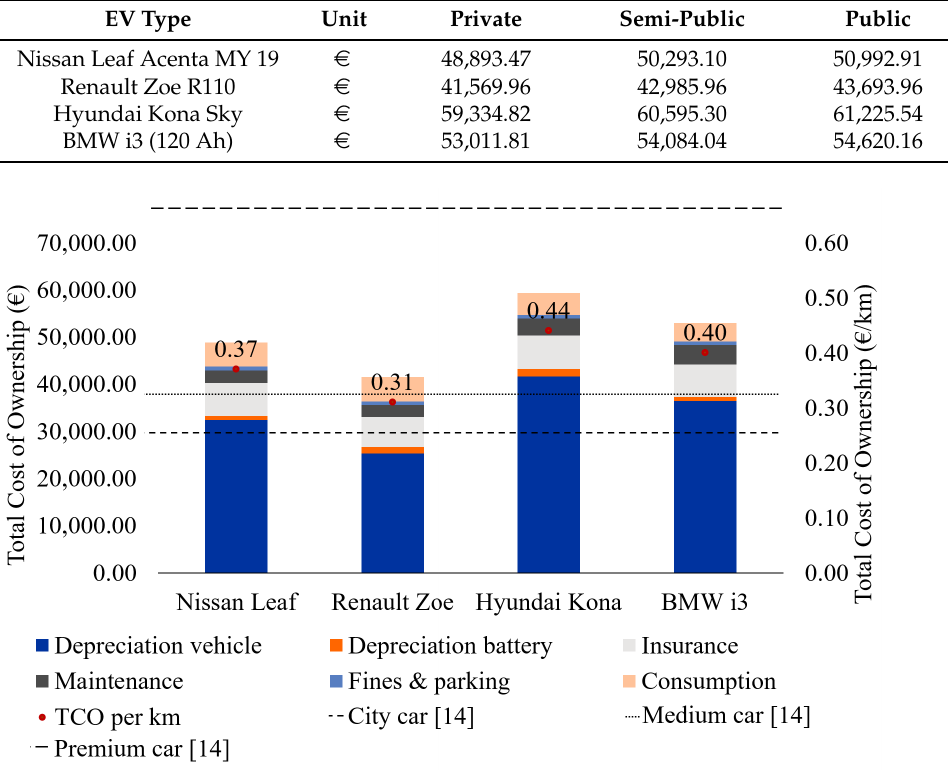
Table 9. TCO without V2G impacts of different charging cases (source: own compilation).